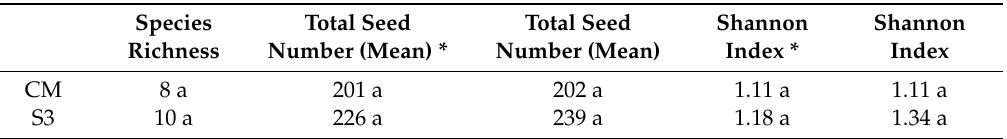
Table 8. Species richness identified in the seed bank analysis and total seed number (seeds × litre soil − 1 ). CM: cereal monocrop, S3: sainfoin in the third year.